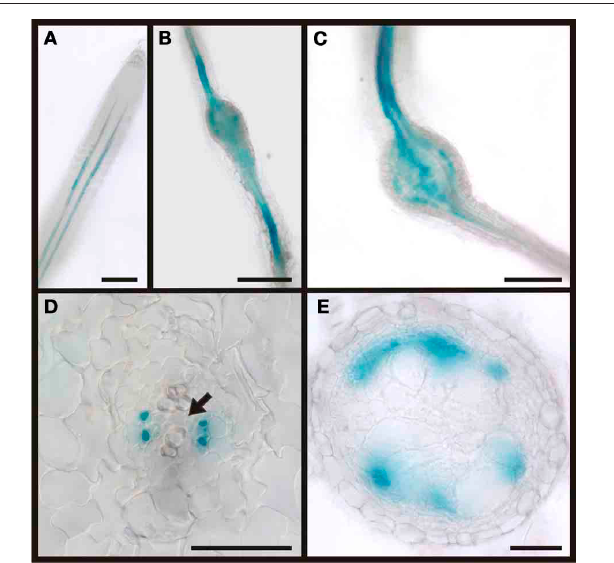
FIGURE 12 | Activity of the APL promoter visualized by GUS staining in P APL :GUS plants. In control sections of plants roots infected with M. incognita staining is observed in two cell files within the stele ( A) . In root knots 7dai the staining is limited to the stele but also observed in patches within the root knot (B) . In mature root knots 17dai staining is observed in a net-like pattern in cells surrounding the giant cells (C) . (D,E) Cross sections through a root knot 17dai. (D) section through the very beginning of the root knot indicated by the separation of the xylem elements (arrow). GUS staining is limited to four cells, probably companion cells. (E) Cross section through the center of the root knot. Promoter activity indicated by the GUS staining is observed in the cells surrounding giant cells. Scale bars represent 100 µ m in (A) , 200 µ m in (B,C) and 50 µ m in (D,E)